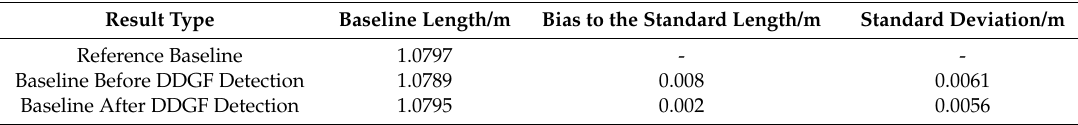
Table 5. The statistic results of different baseline lengths in the urban vehicle